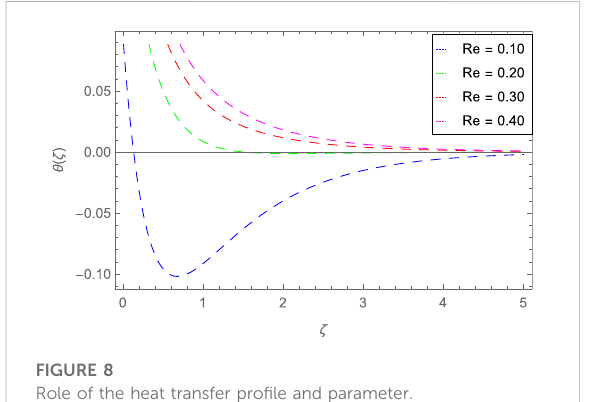
FIGURE 8 Role of the heat transfer pro fi le and parameter.